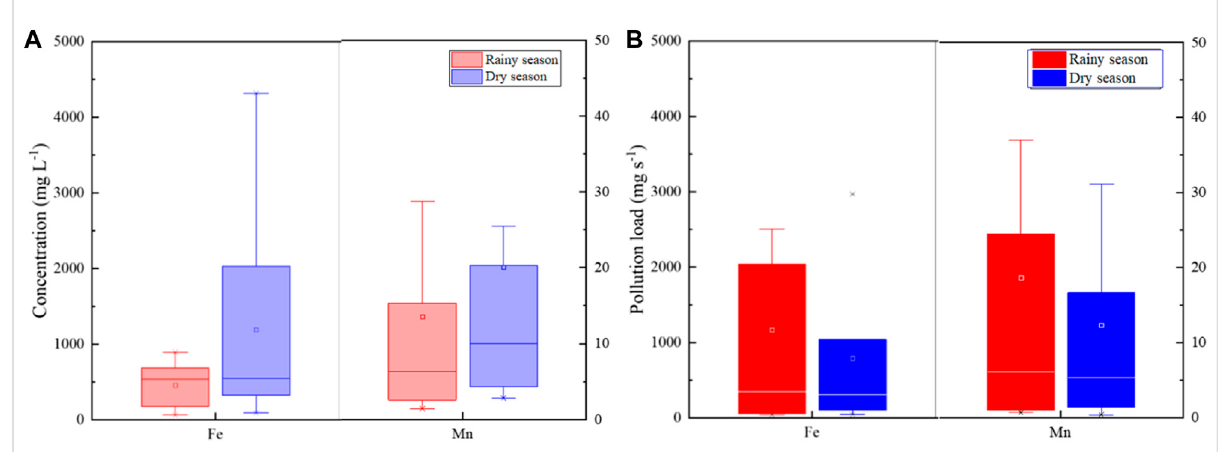
FIGURE 6 Comparison of the concentration (A) and pollution load (B) change for Fe and Mn in 24 ARD samples in different seasons.